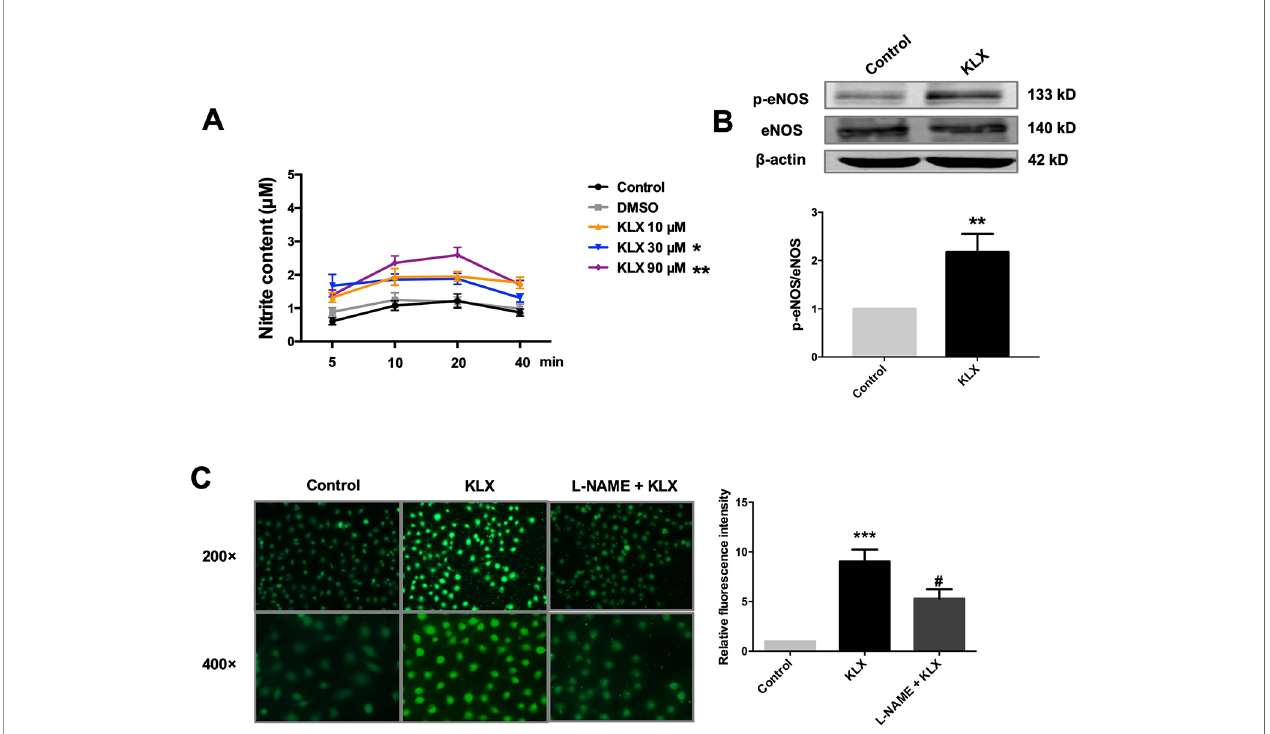
FIGURE 3 | KLX enhances phosphorylation of eNOS and production of NO. (A) Promoting effect of KLX on NO production in cultured HUVECs. HUVECs were pretreated with different concentrations of KLX (10, 30, 90 µM) for 5, 10, 20, 40 min respectively. Then the content of nitrite (which represents NO concentration) in cell culture medium of different incubation time and different KLX concentrations was determined using Griess reagent assay. Data were presented as the relative value by taking the nitrite content of control group at different time points as a reference, * p < 0.05, ** p < 0.01 vs control, n = 6. (B) Enhancing effect of KLX on eNOS phosphorylation in cultured HUVECs. ** p < 0.01 vs control, n = 6. (C) Representative images (left panel) and statistical data (right) of fl uorescence staining of NO showing the suppressing effect of L-NAME (a NOS inhibitor) on KLX-induced NO production in cultured HUVECs. Data are presented as mean ± SEM, *** p < 0.001 vs control, # p < 0.05 vs KLX, n =